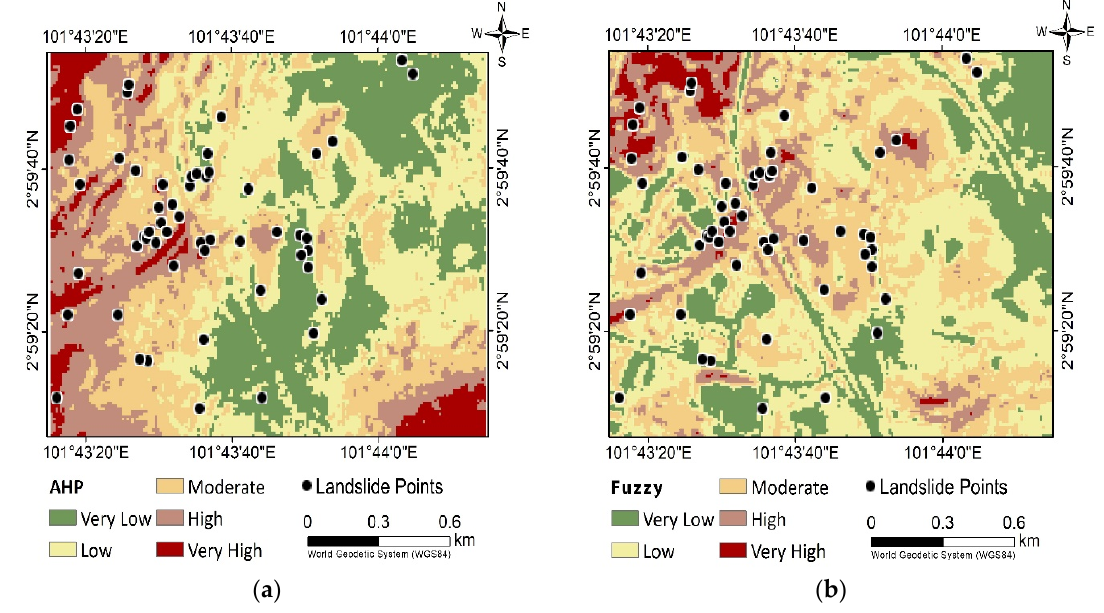
Figure 5. Landslide susceptibility map by ( a ) AHP and ( b ) fuzzy GAMMA overlay models. Table 4. The level of risk (Australian Geo-Mechanics